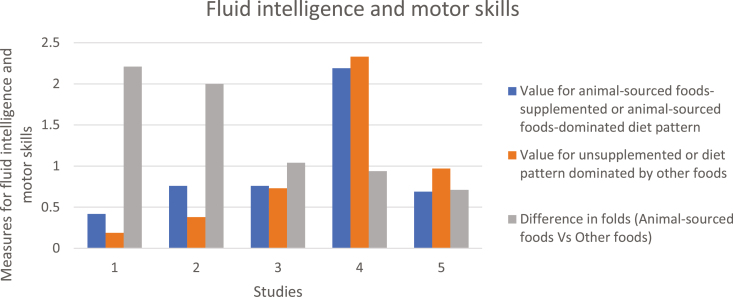
Comparison of Fluid intelligence and motor skills measures between subjects supplemented with animal-sourced foods or have animal-sourced foods-dominated diet patterns and subjects supplemented or with diet patterns dominated by other foods. Results are from five studies 1: (Petrova et al., 2018), 2 and 3: (Heys et al., 2010), 4: (Khee Loo et al., 2017), 5: (Smithers et al., 2012). Five measures of fluid intelligence summarized include 1: Symbol/animal search; 2: 10 word-word recall; 3: 10 word-word recall (adjusted for age, sex and education); 4: Fluid intelligence (Ravens progressive matrices); 5: Intelligence Quotient (IQ)